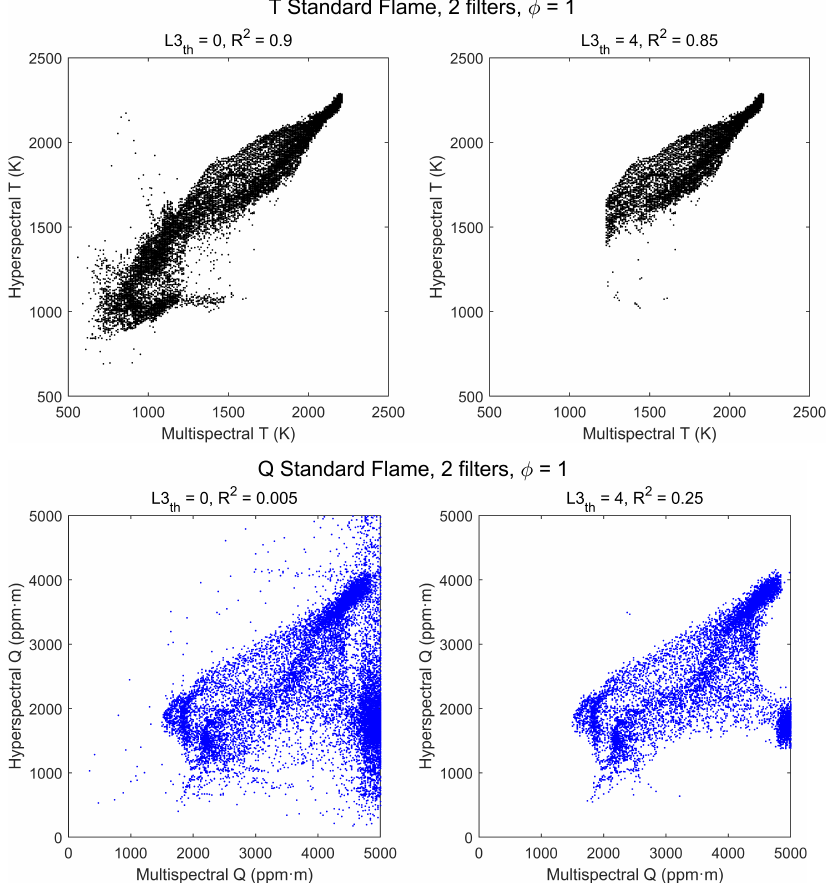
Figure 13. Scatterplots of hyperspectral vs. multispectral retrieved values of T ( top row ) and Q ( bottom row ) for the stoichiometric ( φ = 1) standard flame, using only filters 1 and 3 for retrieval. Each point corresponds to a pixel, with no threshold radiance ( left column ) and with threshold L3 th = 4 W/m 2 · sr · cm − 1 ( right column ).